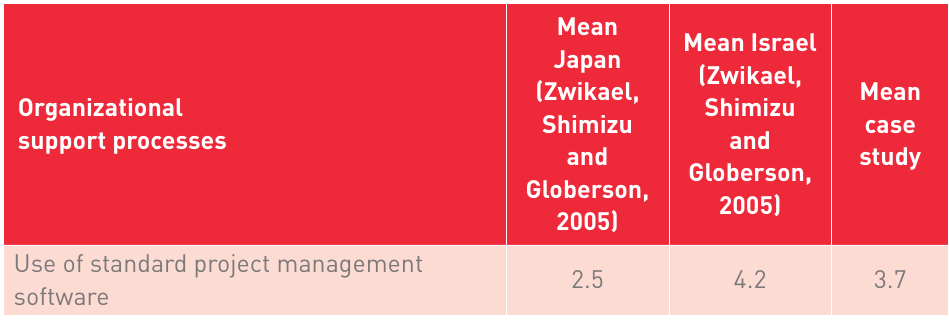
Level of applied organizational support processes between Japan, Israel and the studied